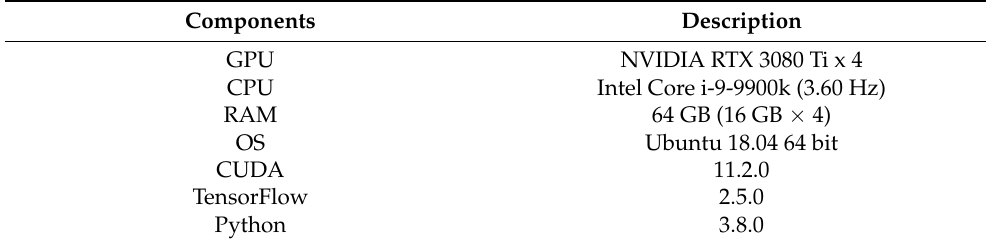
Table 1. Environmental setup of the